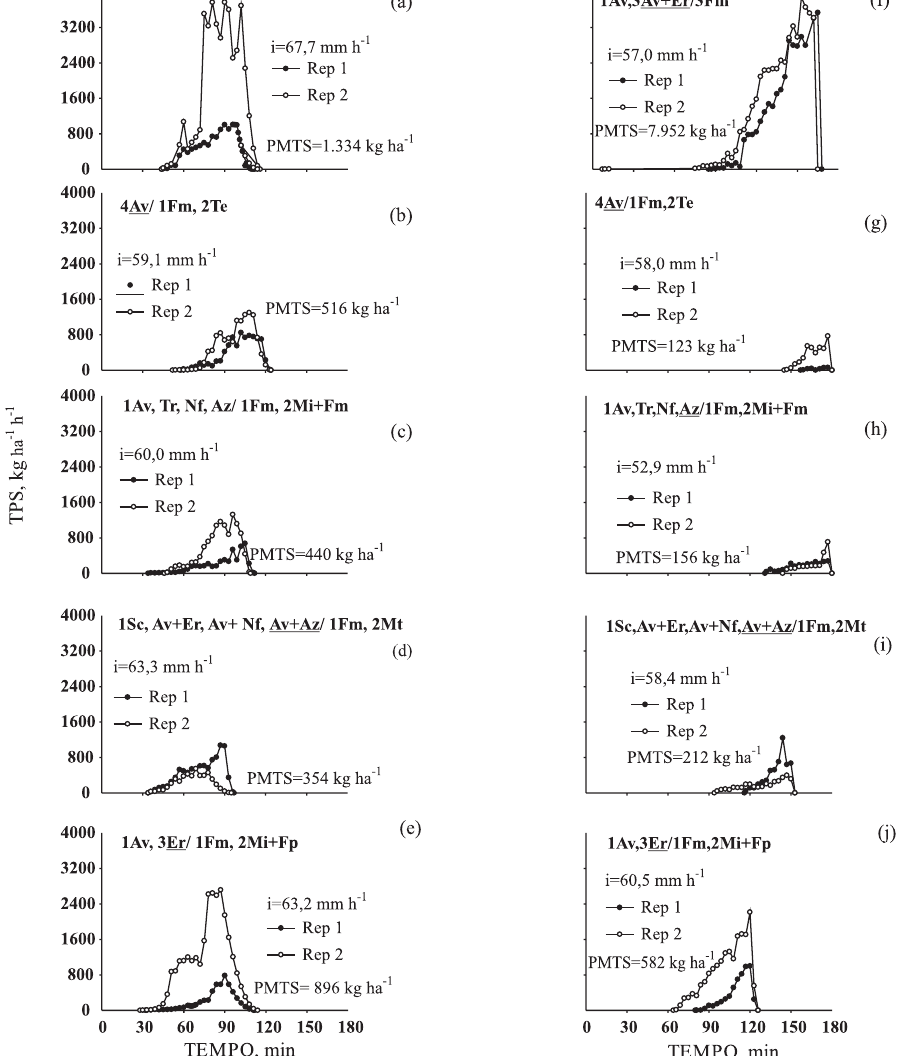
Figura 7. Taxas instantâneas de perda de solo (TPS) no quinto (T5: solo previamente escarificado – em T4, raízes mortas, 18 % coberto – figuras (a) a (e), à esquerda) e no sexto (T6: solo recém-gradeado – após T5 - , raízes mortas, 0 % coberto – figuras (f) a (j), à direita) teste de erosão com chuva simulada, nas sequências culturais estudadas (Av: aveia-preta, Er: ervilhaca, Fm: feijão-miúdo, Te: teosinto, Tr: trevo-calypso, Nf: nabo forrageiro, Az: azevém, Mi: milho, Sc: sem cultivo, Mt: milheto e Fp: feijão-de-porco. Valores individuais para cada repetição dos tratamentos (Rep 1 e Rep